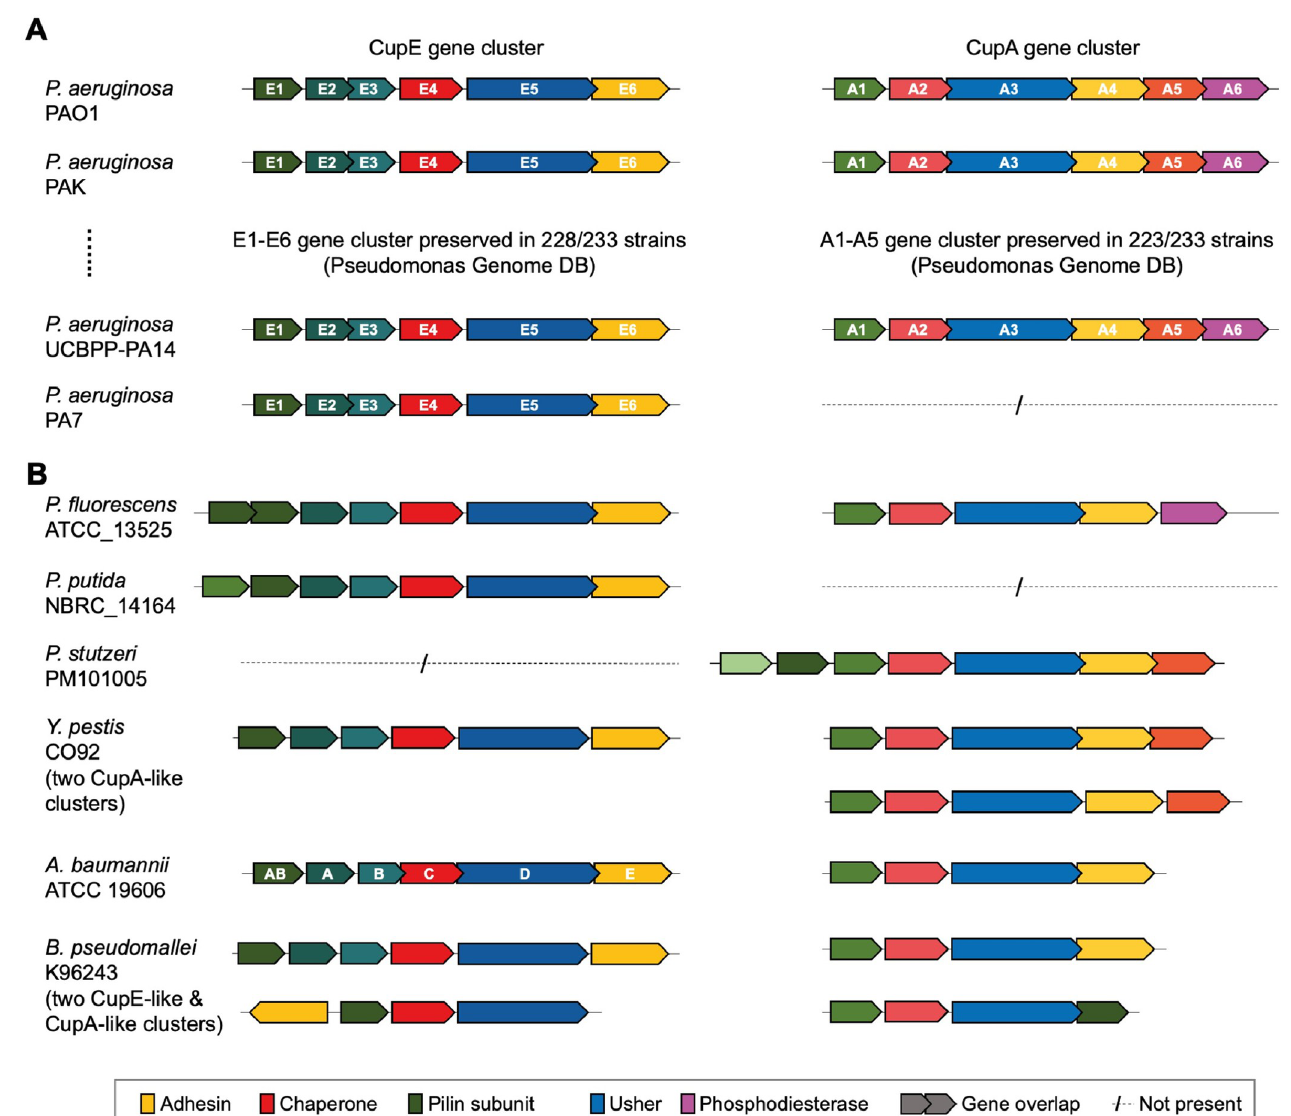
Fig 4. Co-occurrence of cupA and cupE gene clusters. (A) Bioinformatic analysis reveals co-occurrence of the cupA and cupE gene clusters with preserved gene order in most P . aeruginosa strains. Overlapping sequences of different CUP genes indicate possible translational coupling; of the usher gene cupE5 to the adhesive tip subunit gene cupE6 , of the two minor pilin subunits cupE2 and cupE3 , and of all genes cupA2 - cupA6 . A phosphodiesterase (CupA6) is encoded after cupA5 in every strain in which cupA occurs. (B) Outside of P . aeruginosa , examples of co-occurrence can be found in pathogenic proteobacteria such as P . fluorescens , Y . pestis , A . baumannii , and B . pseudomallei . Gene order in CUP clusters outside P . aeruginosa is not preserved; e.g. in P . fluorescens ATCC_13525, an additional pilin is encoded, and in B . pseudomallei K96243, the cupA6- like gene is encoded on the opposite strand. Accession data and gene loci are provided in S5 Table and supplementary file S1